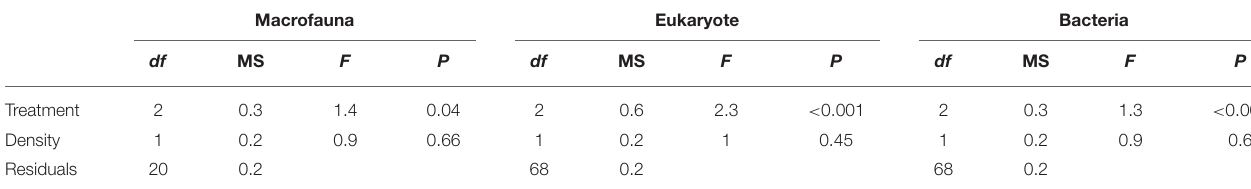
TABLE 1 | Results of PERMANOVA analyses to test the effect of Treatment (“ Sabella ,” “Mimic,” and “Control”) and Sabella spallanzanii Density on macrofaunal, eukaryote and bacterial assemblages.